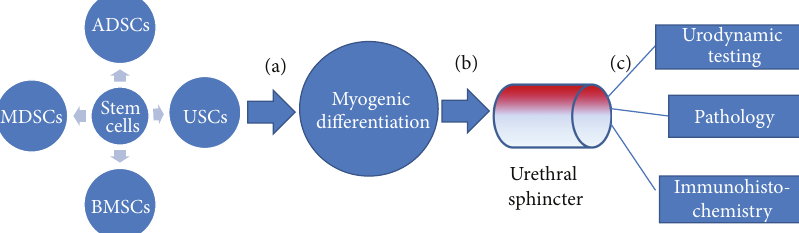
Figure 1: The protocol of stem cell therapy for SUI animal models. In most studies that investigate stem cells as potential treatment for SUI, the following criteria need to be established. (a) The polyphyletic stem cells have plasticity to differentiate into functional cells and proliferate in vitro. Myogenic differentiation is demonstrated with the expression of desmin and a-skeletal muscle actin by immunostaining. (b) They migrate to the damaged external urethral sphincter through periurethral injection. (c) Treatment effects of stem cell transplantation were evaluated through urodynamic testing and morphologic changes of the urethra and frozen urethra sections were submitted to pathology and immunohistochemistry assessment before and after